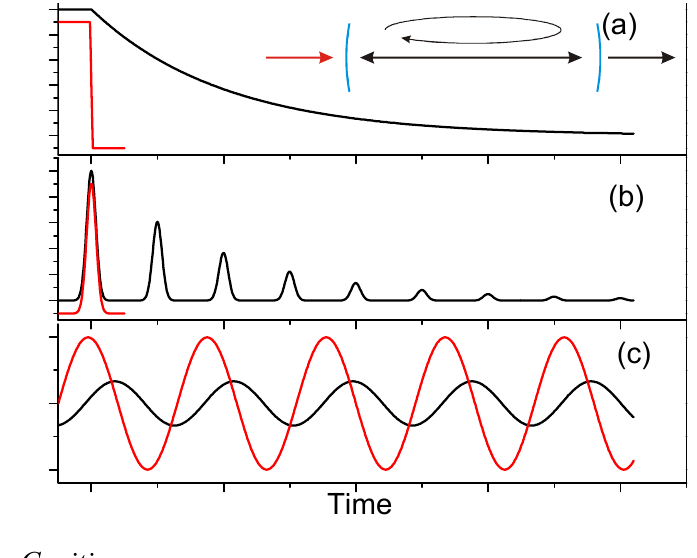
Figure 1. Different implementations of cavity ring-down measurements (a) In time-resolved continuous wave CRD the light entering the cavity (see inset) is switched quickly (red line), and the intensity decay in the cavity is monitored from the cavity build-up time or the ring-down time (black). (b) If the injected pulse (red) is short compared to the round-trip time, t , the ring-down time is obtained from the exponential decay constant of the rt amplitudes of the light pulses that are leaked from the cavity with each round trip (black). (c) In phase-shift cavity ring-down the light intensity of a cw-source is modulated sinusoidally (red). The cavity introduces a phase-shift (black) that is related to the losses in the cavity and therefore to the ring-down